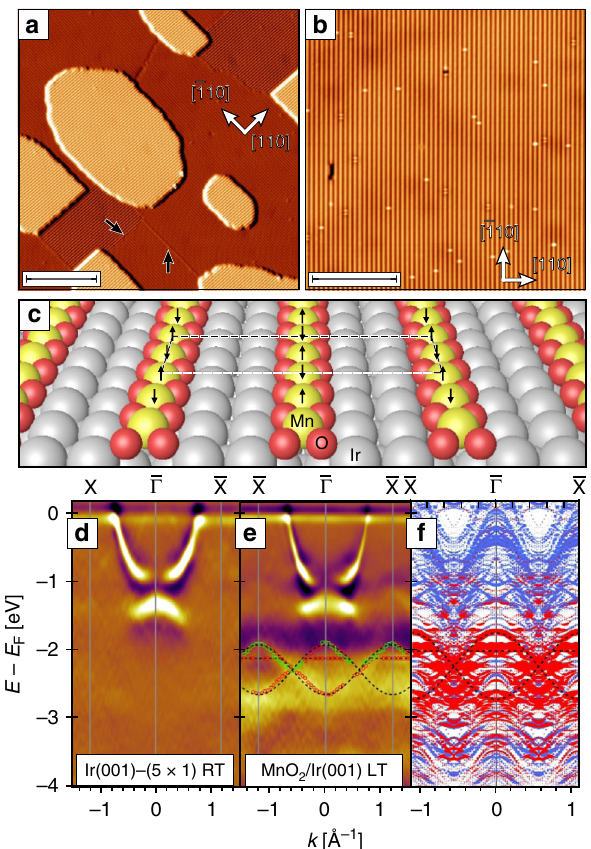
Fig. 1 Structural and electronic properties of MnO 2 on Ir(001). a Large scale STM image showing islands of monolayer height (scale bar: 25 nm). The entire surface including the islands are covered by chains along the [110] or ½ 110 (cid:2) direction. b Higher resolution STM image of the MnO 2 chains (scale bar: 15 nm). Scan parameters: U = 1 V, I = 300 pA. c Schematic model of the atomic structure and the AFM (6 × 2) spin arrangement predicted in ref. 17 . d , e Second derivative ARPES data of the Ir(001)-(5 × 1) surface (at room temperature, RT) and for MnO 2 /Ir(001) (at 13 K, LT) along the Γ — X direction ( h ν = 150 eV). Red and green symbols mark the dispersion of Mn- related states as determined from data taken at h ν = 150 eV and 130 eV, respectively. Their periodicity is in agreement with the 2× AFM order expected along the chains. Dashed lines are guides to the eye. f DFT band structure of MnO 2 /Ir(001) exhibiting AFM order along the chains. Red and blue dots represent Mn and Ir states, respectively. The size of the symbols indicates the surface localization of the corresponding state. The same dashed lines shown in e (stretched by a factor 1.33 to consider the larger band width in DFT) agree well with surface-localized Mn